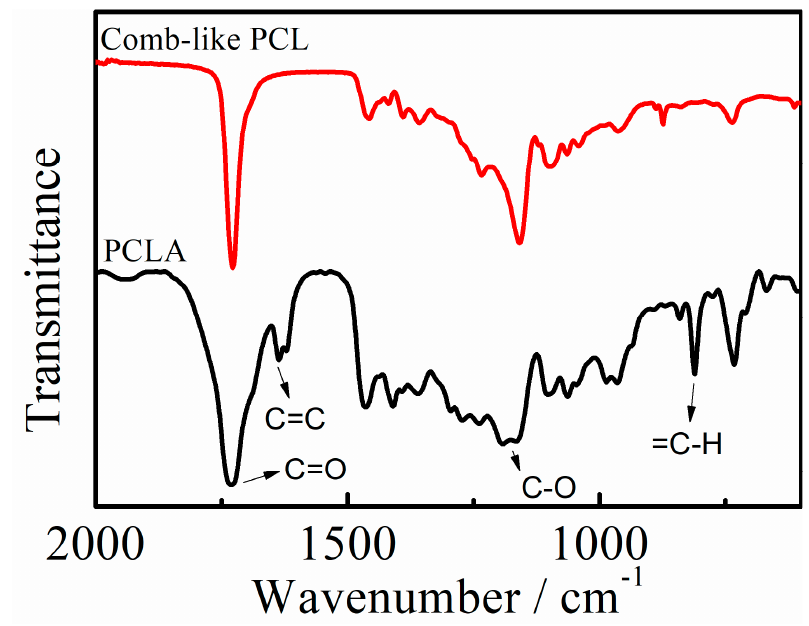
Figure 2. The FTIR results of the PCLA precursor and the comb ‐ like PCL thereof.